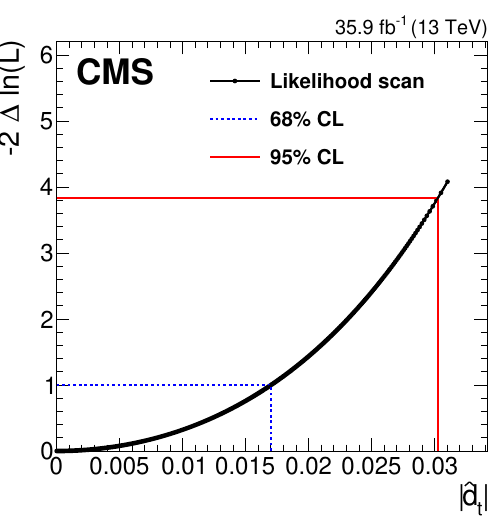
Figure 8 . One-dimensional likelihood pro(cid:12)le of the ^ d parameter, where the change in the minimum t log likelihood from its global minimum ( (cid:0) 2(cid:1) ln L ) is shown on the y -axis as a function of j ^ d dashed and solid lines show the intersections at (cid:0) 2(cid:1) ln L = 1 : 0 and 3 : 84, corresponding to the one-sided limits on j ^ d j at the 68 and 95% con(cid:12)dence limits, respectively. t